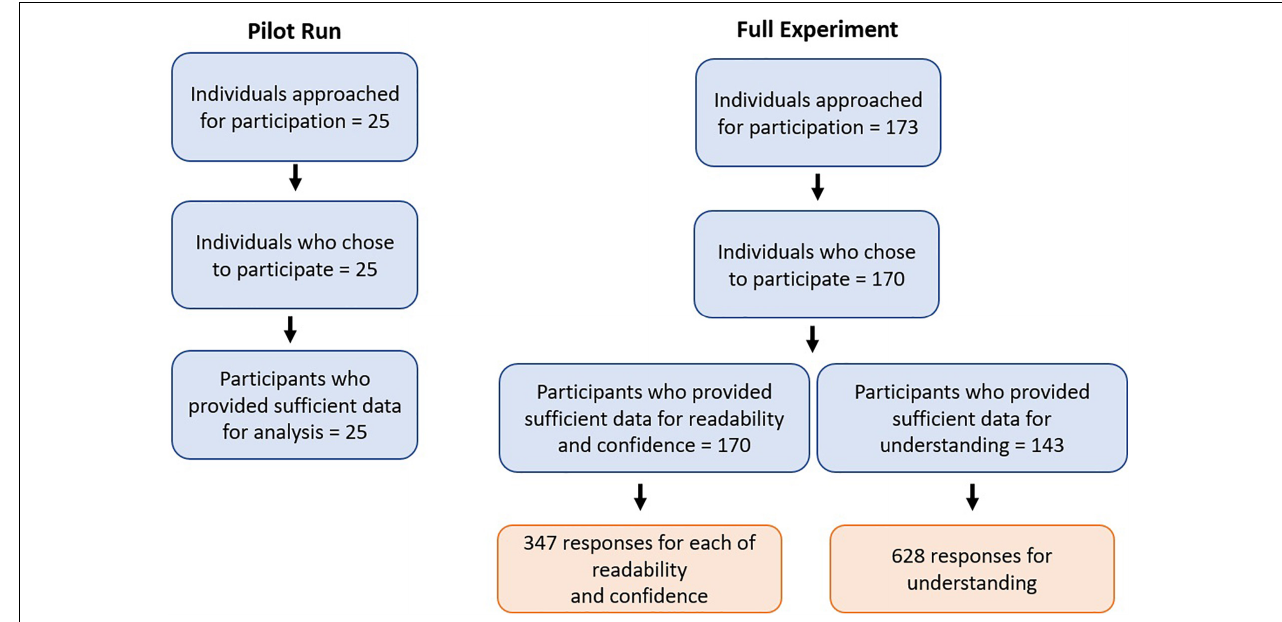
FIGURE 1 | Flow of participants through the pilot run and the full experiment.